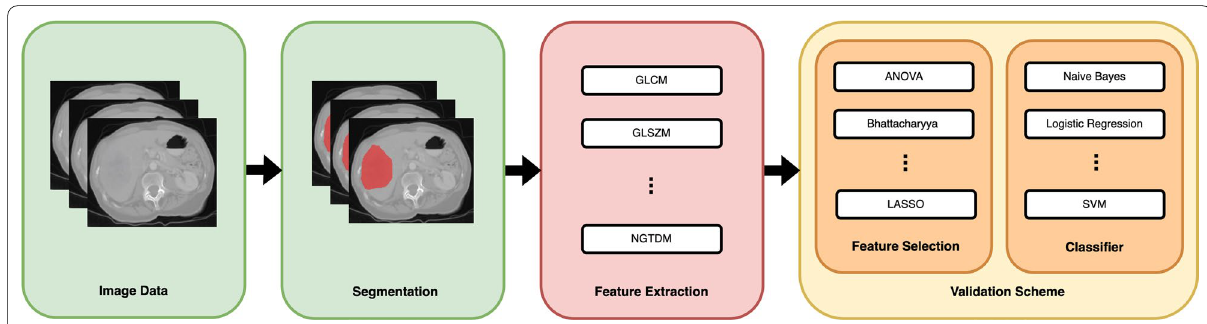
Fig. 1 General radiomics